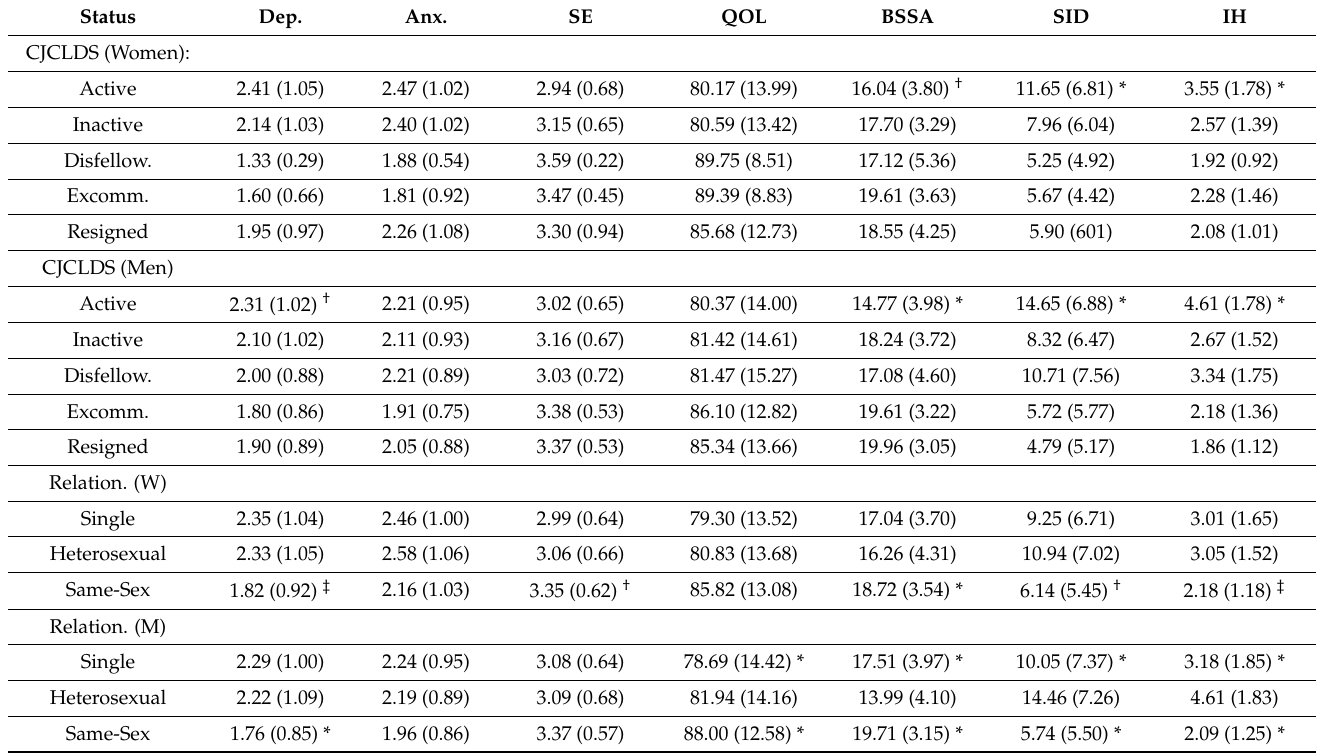
Table 6. Mental and Sexual Health Measures by CJCLDS and Relationship